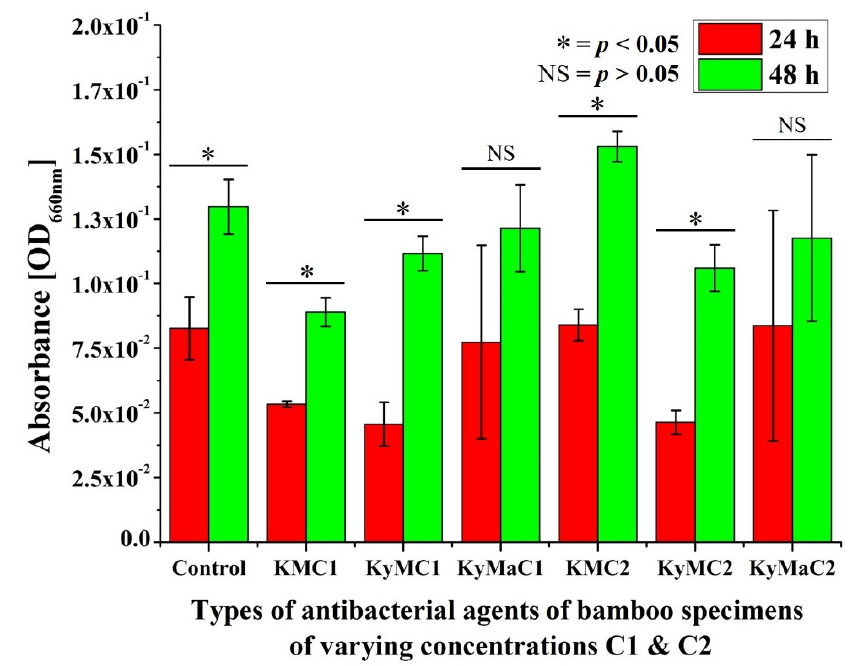
Figure 4. Absorbance results of various types of antibacterial agents of bamboo specimens of differing concentrations, C1 and C2, after in vitro testing with S. aureus for 24 h and 48 h periods (* statistically significant difference, NS = no significant